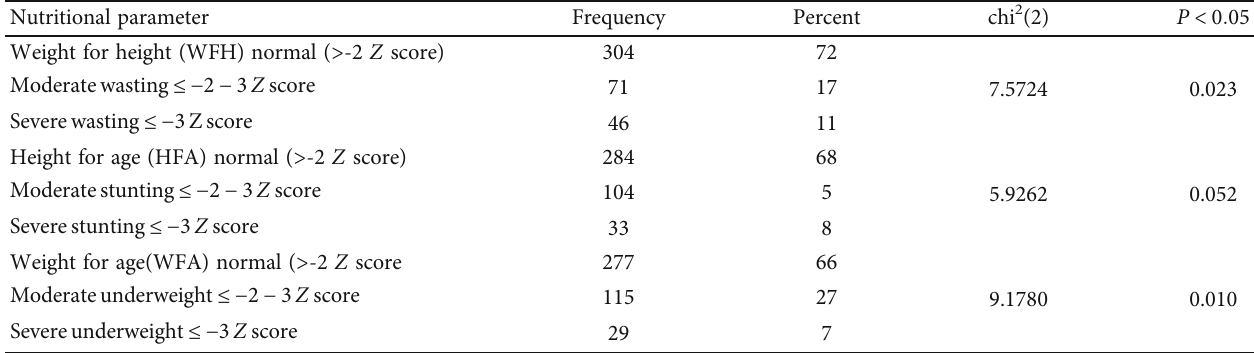
Table 2: Baseline nutritional status of seropositive children attending HIV/AIDS care in two public hospitals North West Ethiopia 2021 ( N = 421 ).